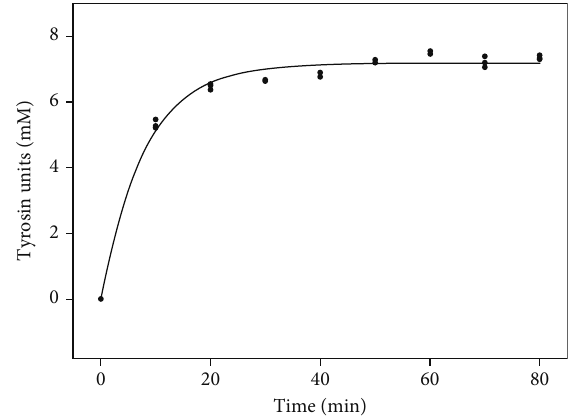
Figure 4: Kinetic of caseins hydrolysis by trompillo proteases at 30 ° C and pH 7. Values represent the average of triplicates ( n = 3 ).